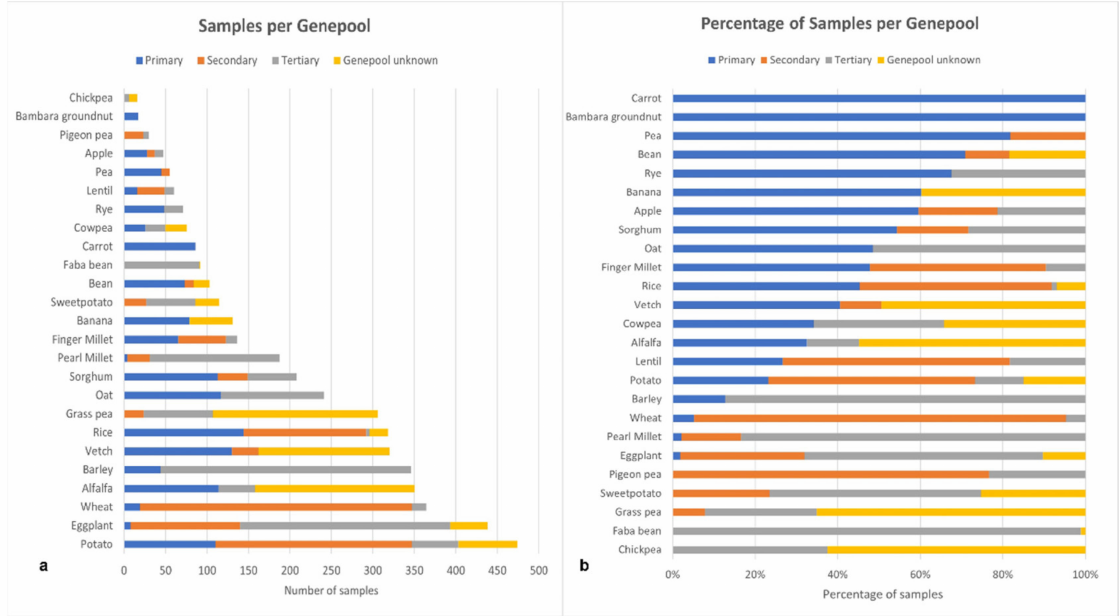
Figure 3. Samples collected per crop genepool categorized by their relationship to the crop. Samples are defined as primary (blue), secondary (dark orange) or tertiary (gray) genepool taxa, or other taxa within the same genus as the crop but whose relationship to the crop is unknown (light